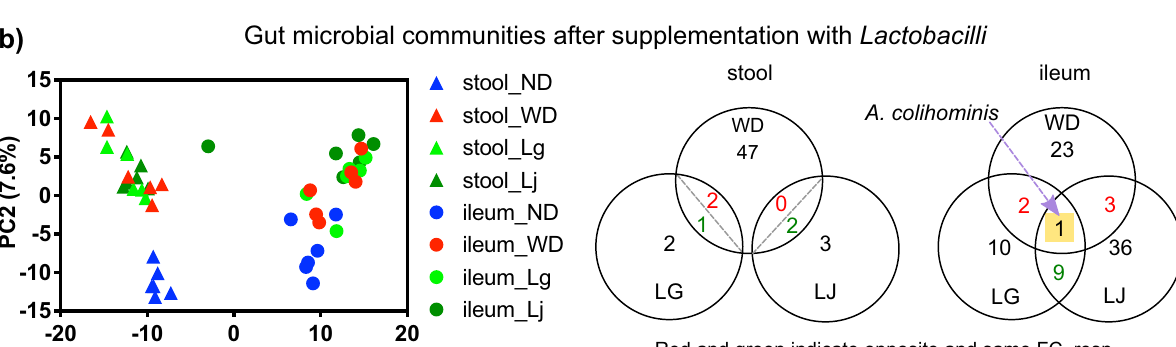
Fig. 3 Experimental validation of microbial candidates. a Metabolic parameters in mice given control diets and supplemented with or without the indicated microbe. Glucose tolerance test (GTT) curves show the mean and SD of blood glucose over time. Open and closed circles indicate two independent experiments; * indicates statistically signi fi cant differences in levels of the parameter between control group (WD for Lactobacilli , ND for R. ilealis ) versus those supplemented with bacteria (one-tail t test p value <0.05 with FDR < 15%). Blue, ND; red, WD; light green WD with L. gasseri (WD + LG); dark green, WD with L. johnsonii (WD + LJ); orange, R. ilealis (ND + RI), respectively. Source data are provided as a Source Data fi le. b Principal Component Analysis of stool (triangle) and ileal (circle) microbial communities and Venn diagram of microbes changed in mice on ND, WD, WD + LG or WD + LJ and with >0.1% median abundance in at least one group across experiments (Fisher ’ s p value <0.05 calculated using two-tail Mann – Whitney per experiment). For Lactobacilli supplementation experiments, n = 11 mice for ND, WD and WD + Lg groups, n = 10 mice for WD + Lj group. For R. ilealis (ND and ND + RI), n = 5 mice per